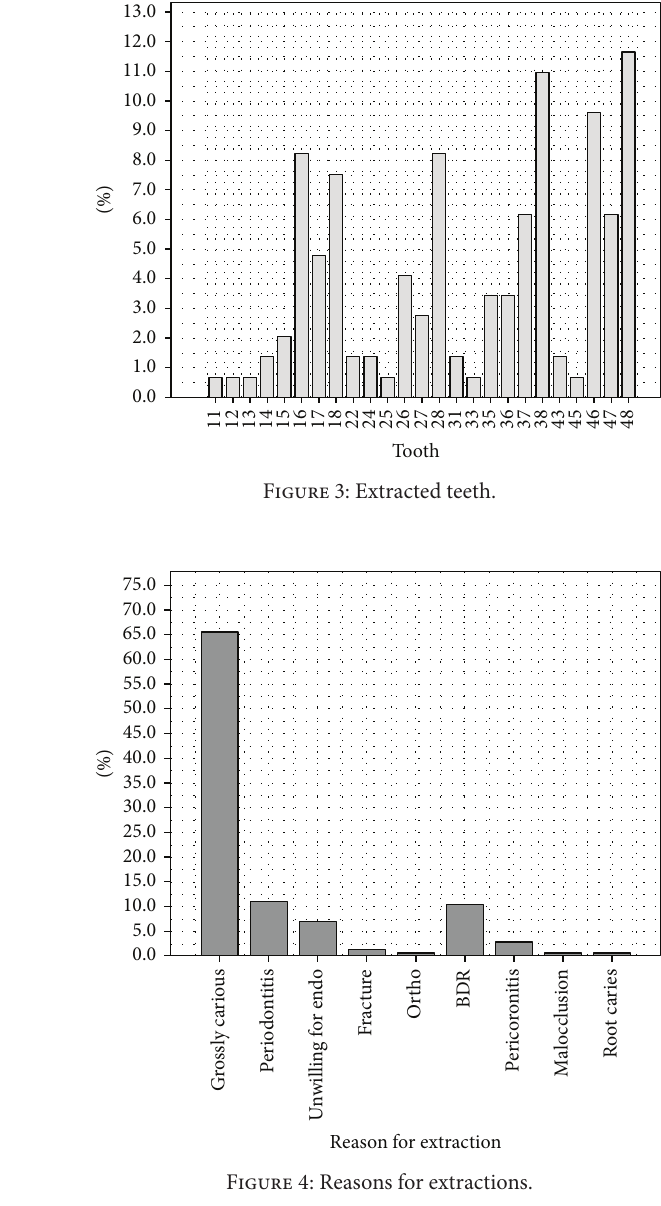
Figure 4: Reasons for